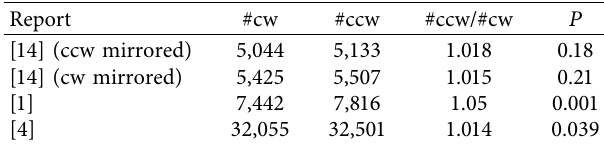
Table 2: Te distribution of galaxies spinning clockwise and counterclockwise in previous reports using SDSS galaxies with spectra.